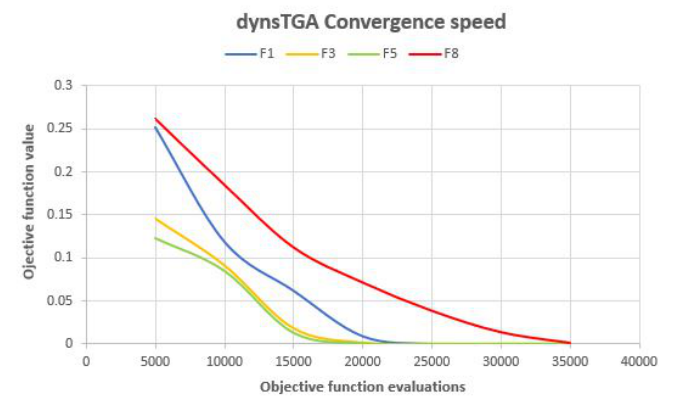
Figure 2. Dynamic search tree growth algorithm (dynsTGA) convergence speed for some unconstrained benchmarks.